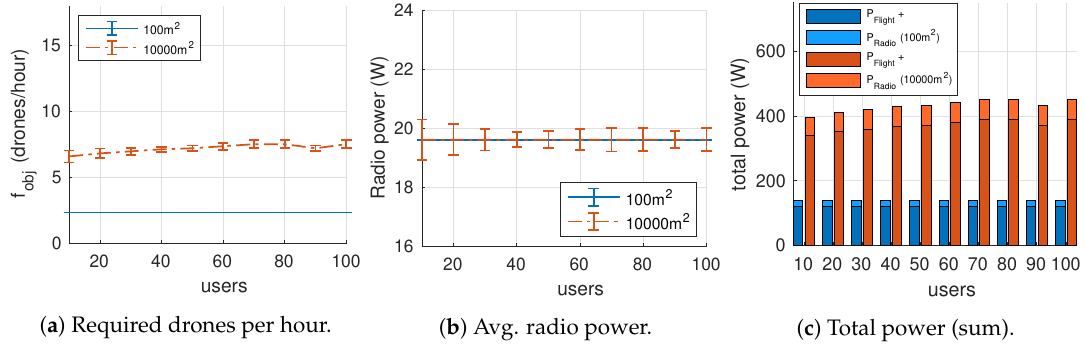
Figure 8. Results for the broadcast VoIP channels